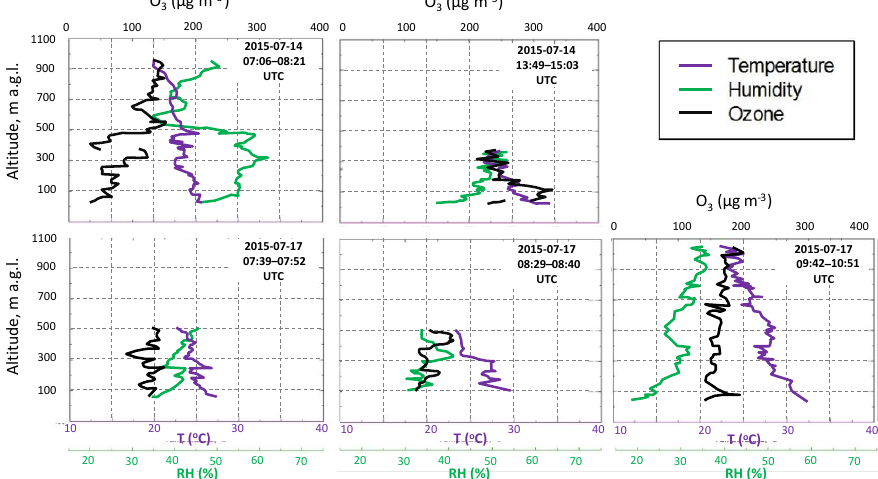
Figure 11. Vertical profiles of O 3 , temperature and relative humidity obtained with the tethered balloon measurements on 14 and 17 July